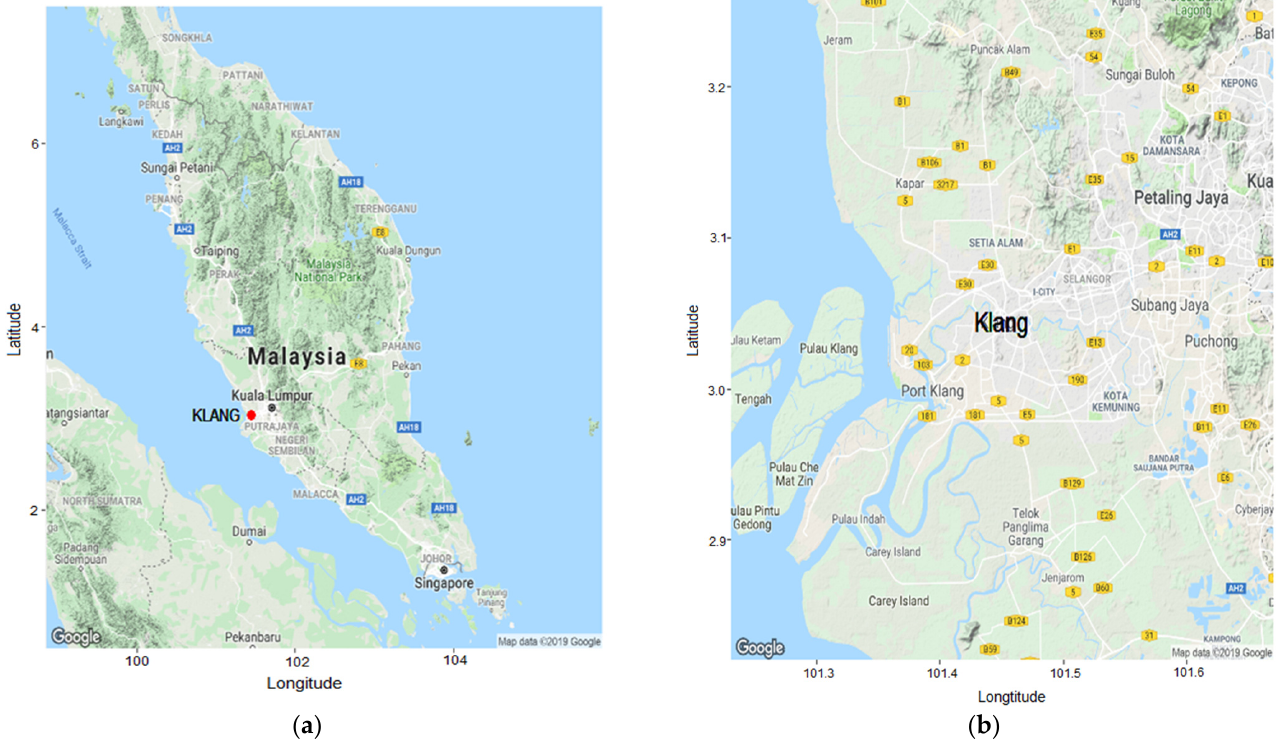
Figure 1. ( a ) Map of Peninsular Malaysia. Klang is identified by the red dot; ( b ) Map of Klang.